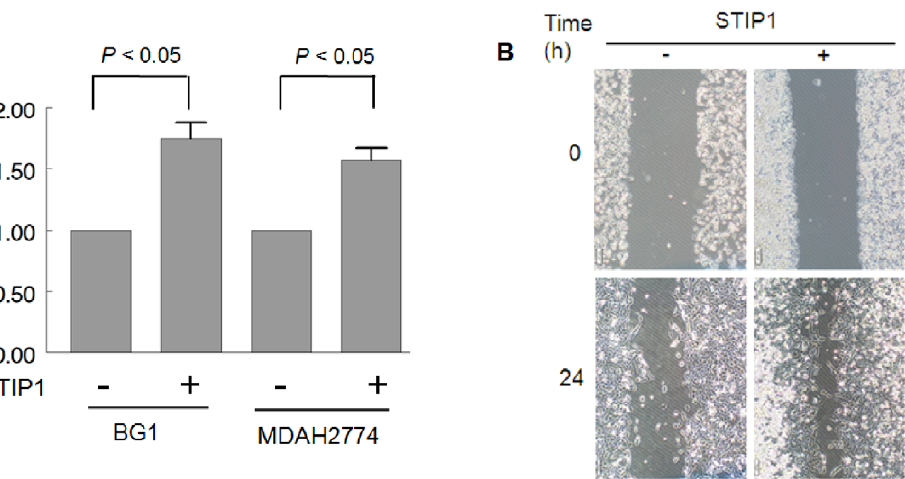
Figure 5. The treatment of ovarian cancer cells with recombinant human STIP1 (rhSTIP1) stimulates cell migration. The treatment with rhSTIP1 promoted cell migration according to the results of both Transwell migration (A) and wound closure (B) assays. Quantitative analysis of the percentage of migrating MDAH2774 cells using the WimScratch software showed that exposure to rhSTIP1 induced a 1.8-fold increase in migration (B). Results are representative of three independent experiments.